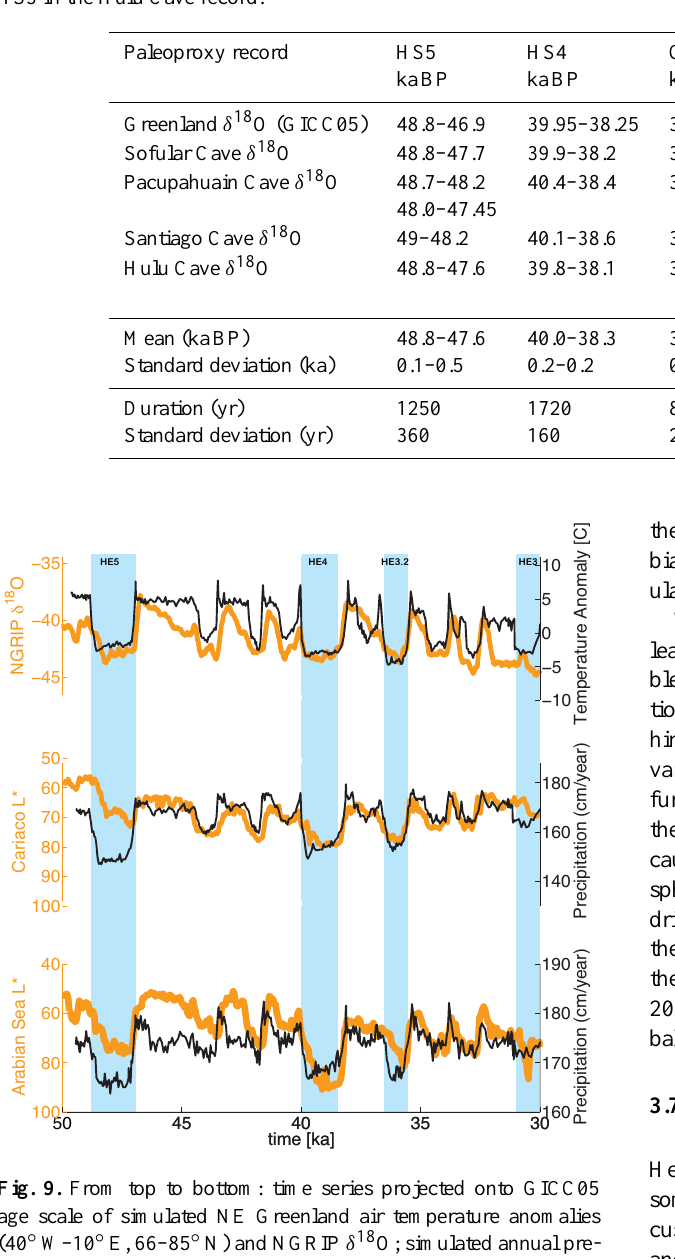
Table 1. Table showing the timing of stadials HS5, HS4, C7/HS3.2 and HS3 as recorded in high-resolution well-dated paleorecords. We calculate the mean (kaBP) and one standard deviation (ka) of the timing of each stadial as well as the duration (yr) of each stadial and its standard deviation (yr). In the Pacupahuain record, the two peaks around HS5 were treated as a single event. A similar method was used for HS3 in the Hulu Cave record.